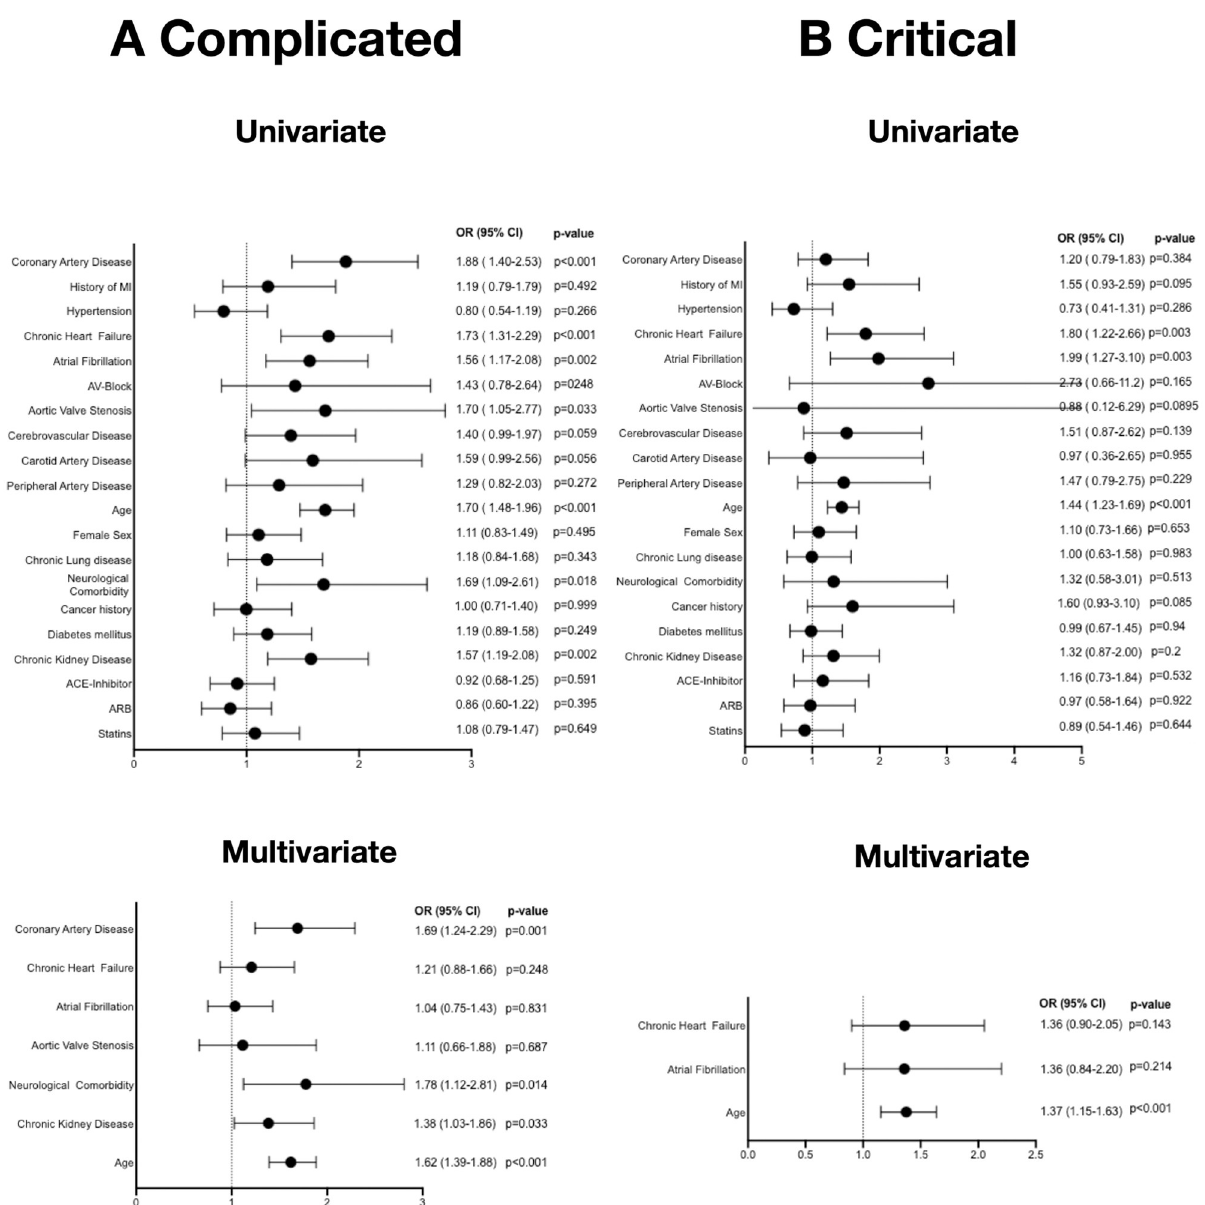
Fig 2. Mortality risk in patients with CVD and hypertension—Advanced disease. Forrest plots of univariate and multivariate analysis for mortality risk for the given clinical characteristics of patients who presented in the complicated phase (n = 620) (A) and those who presented in the critical phase (n = 194) (B)